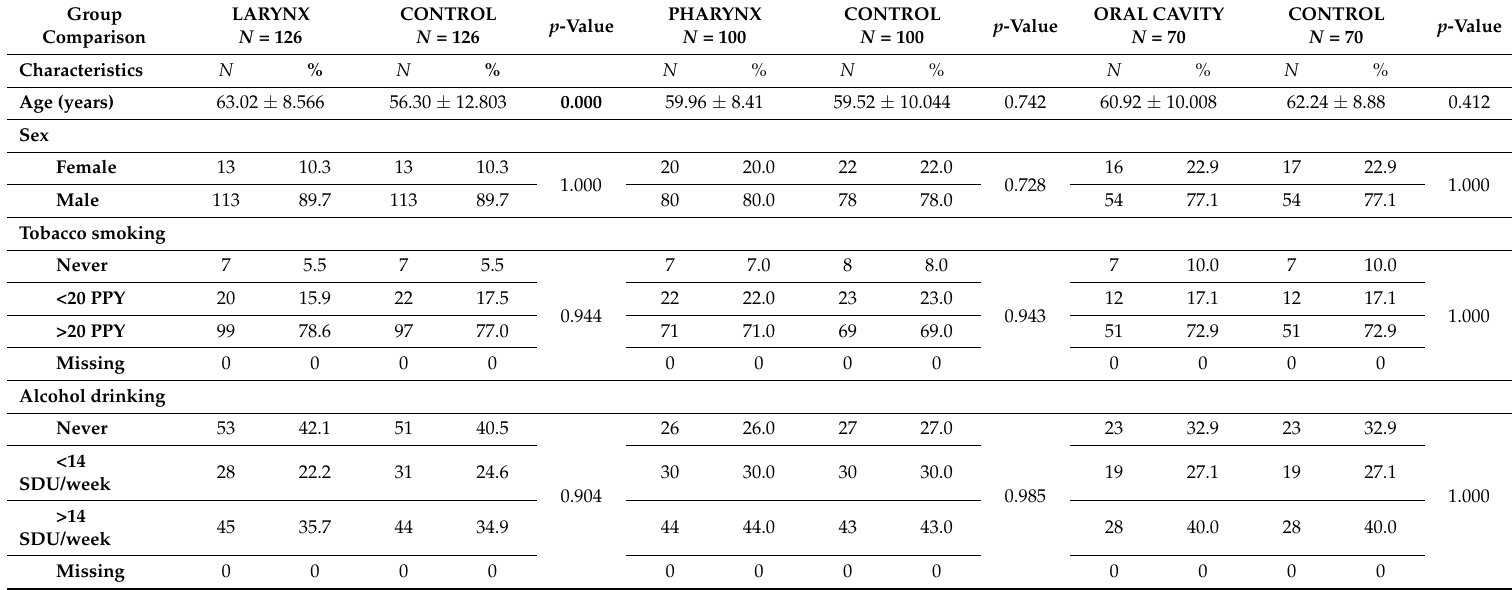
Table 1. Descriptive characteristics and risk factors of paired patients by location in the case-control study. Data after the propensity score method corroborate the equality between the different locations with their specific controls, except for age in laryngeal tumours (introduced as an adjustment variable in the logistic